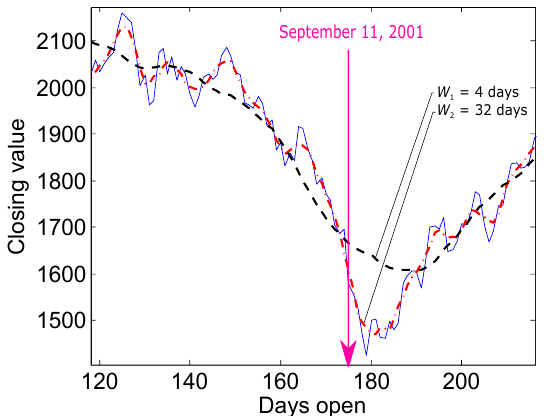
Figure 1. Filtered and unfiltered closing values of the NASDAQ composite index for calendar year 2001. The dashed black line is the first moving average with a four-day window length, and the dotted red line is the second moving average with a 32-day window